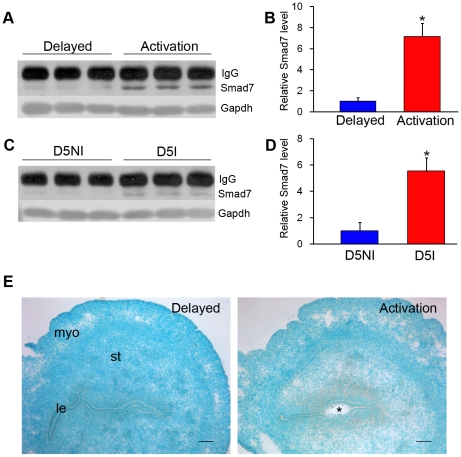
Smad7 expression in mouse uterus.(A) Smad7 protein under delayed implantation and activation by Western blot; (B) Quantification from data in (A); (C) Smad7 protein in mouse uterus on day 5 of pregnancy by Western blot; (D) Quantification from the data in (C); (E) In situ hybridization of Smad7 mRNA expression in mouse uterus under delayed implantation (Delay) and activation. le: luminal epithelium; myo: myometrium; st: Stroma; *: the implanting blastocyst. Bar = 60 µm.